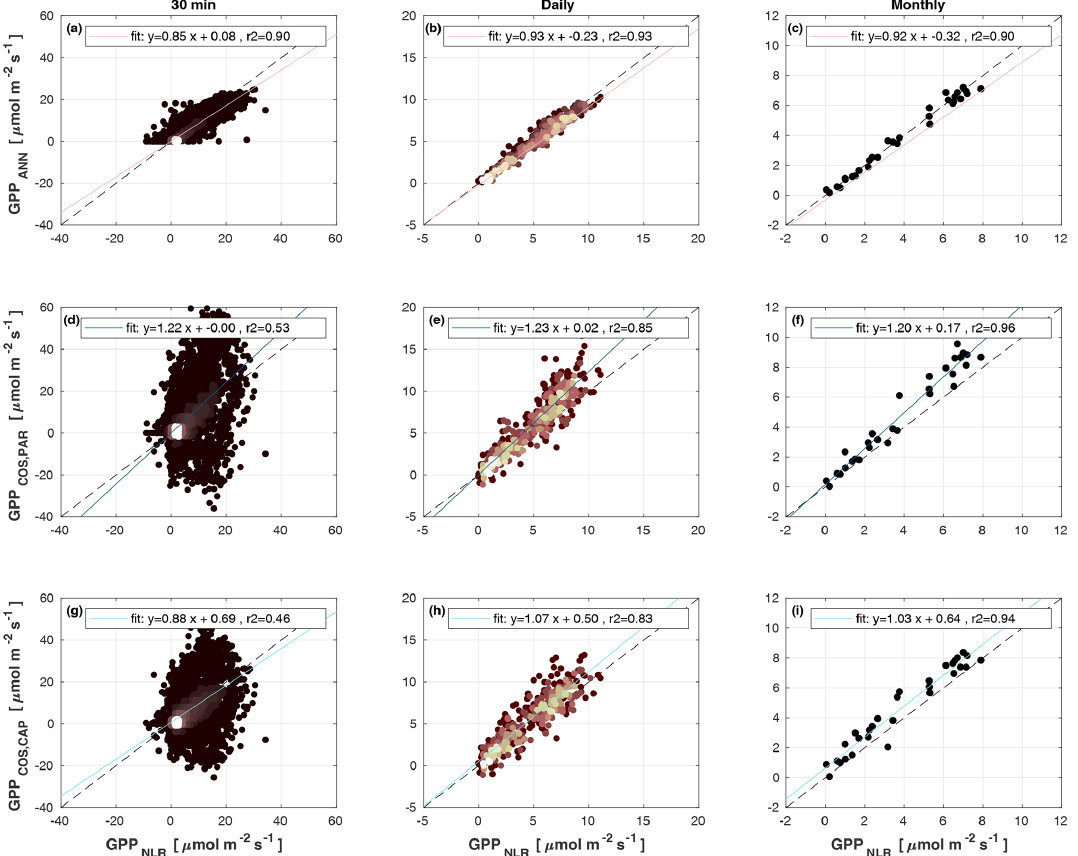
Figure 4. Scatter plots of GPP ANN , GPP COS,PAR , and GPP COS,CAP against GPP NLR in 30min, daily, and monthly timescales. The colour of data points in 30min and daily scatter plots indicates the data density, lighter colours indicating higher point density than dark ones.